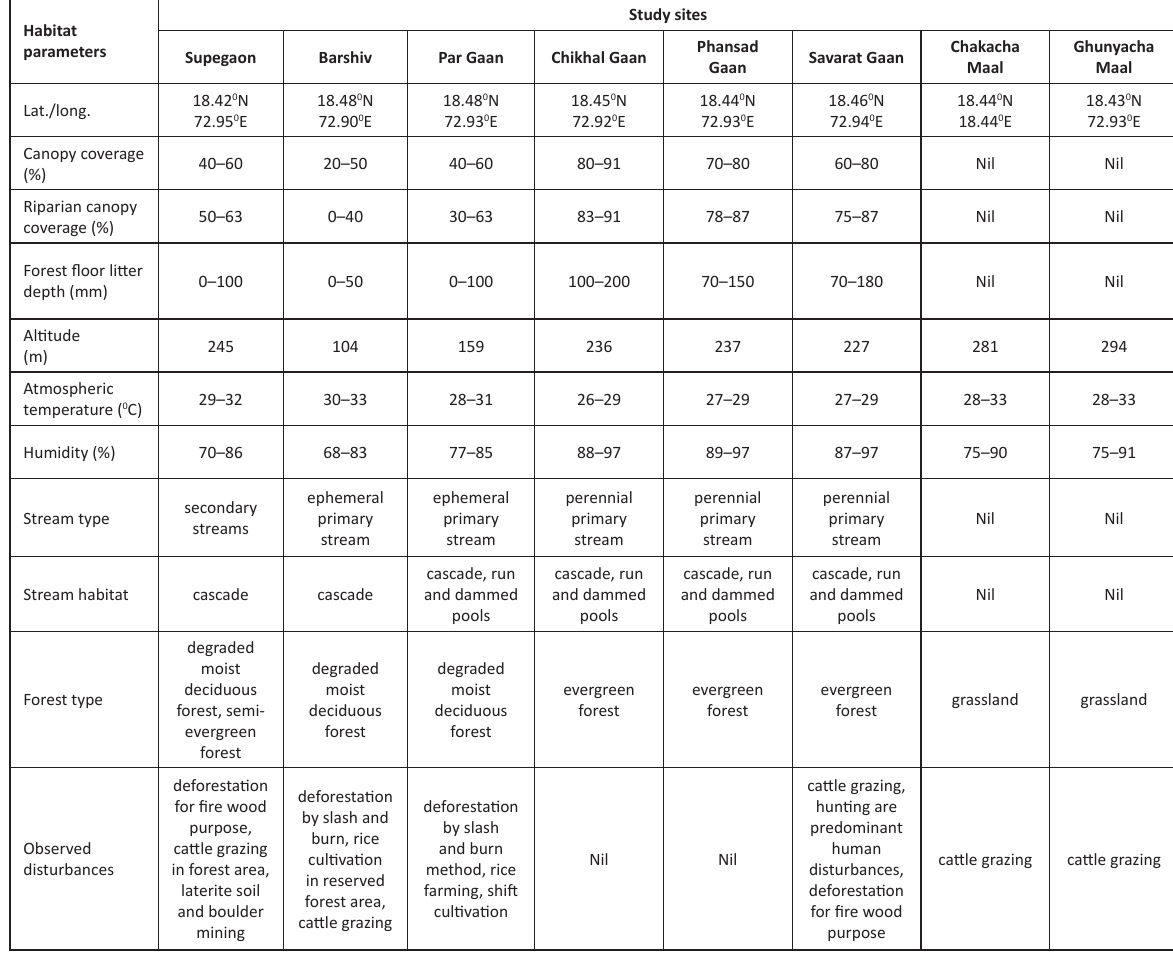
Table 1. habitat parameters recorded at the study